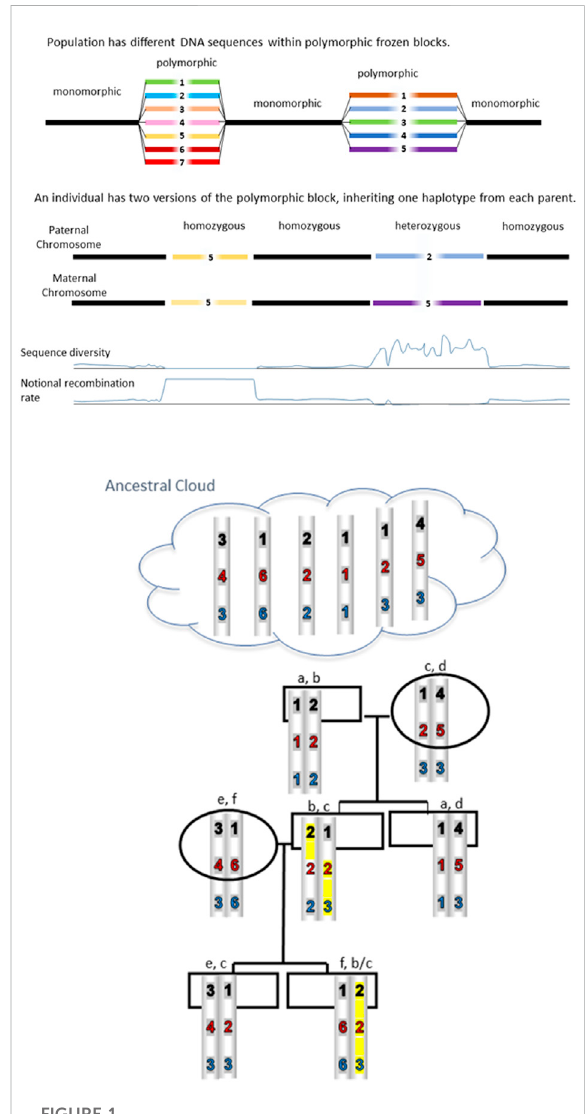
FIGURE 1 CPSs are inherited unchanged from distant ancestors. Blocks are conserved because sequence differences prevent recombination. Some reshuf fl ing is possible when a homozygous block is present. An example is highlighted in yellow where the 123 haplotype has recombined with the 222 haplotype because it is homozygous at the second block thereby creating a 223